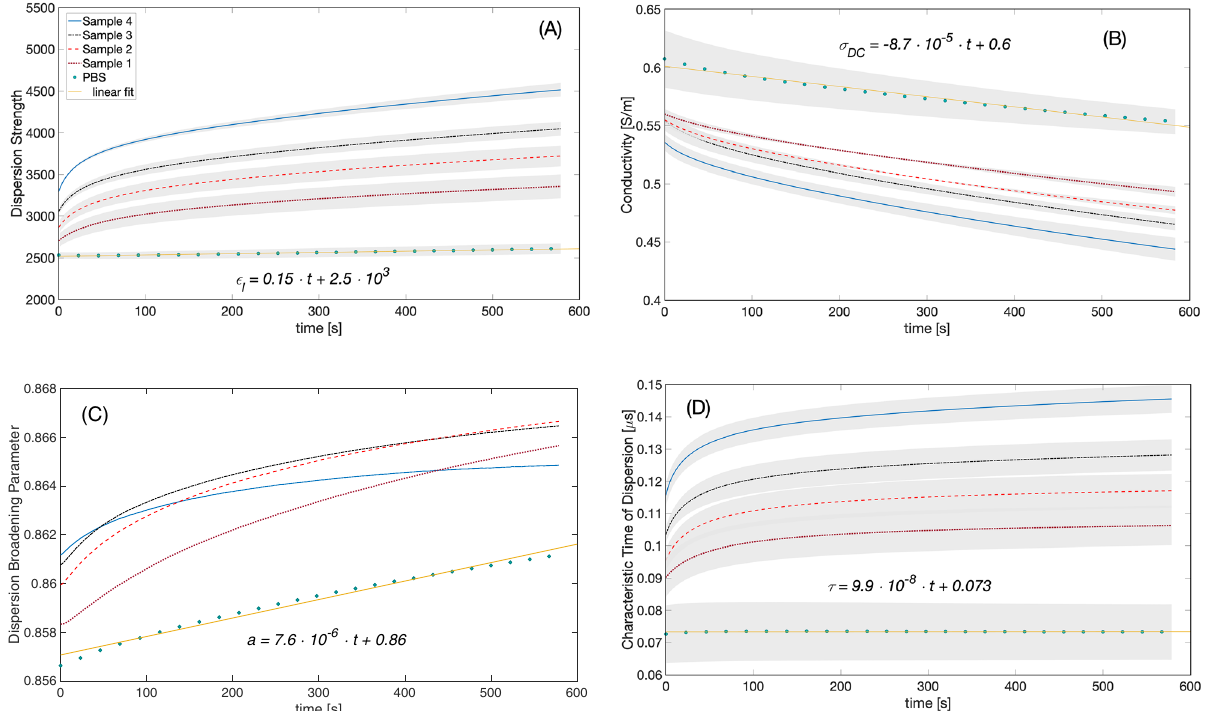
Figure 2. Dispersion strength ( ε l − ε h ) ( a ), conductivity ( σ DC ) (b), dispersion broadening parameter ( a ) ( c ), and dielectric relaxation time constant ( τ ) ( d ) of the blood samples. Different color lines correspond to different samples. Mean data from experiments with hematocrit values 42%, 43%, and 47% are shown. The shaded area around each curve represents the standard error. The standard error is not shown for the dispersion broadening parameter for clarity. The inset equations are linear fits to PBS